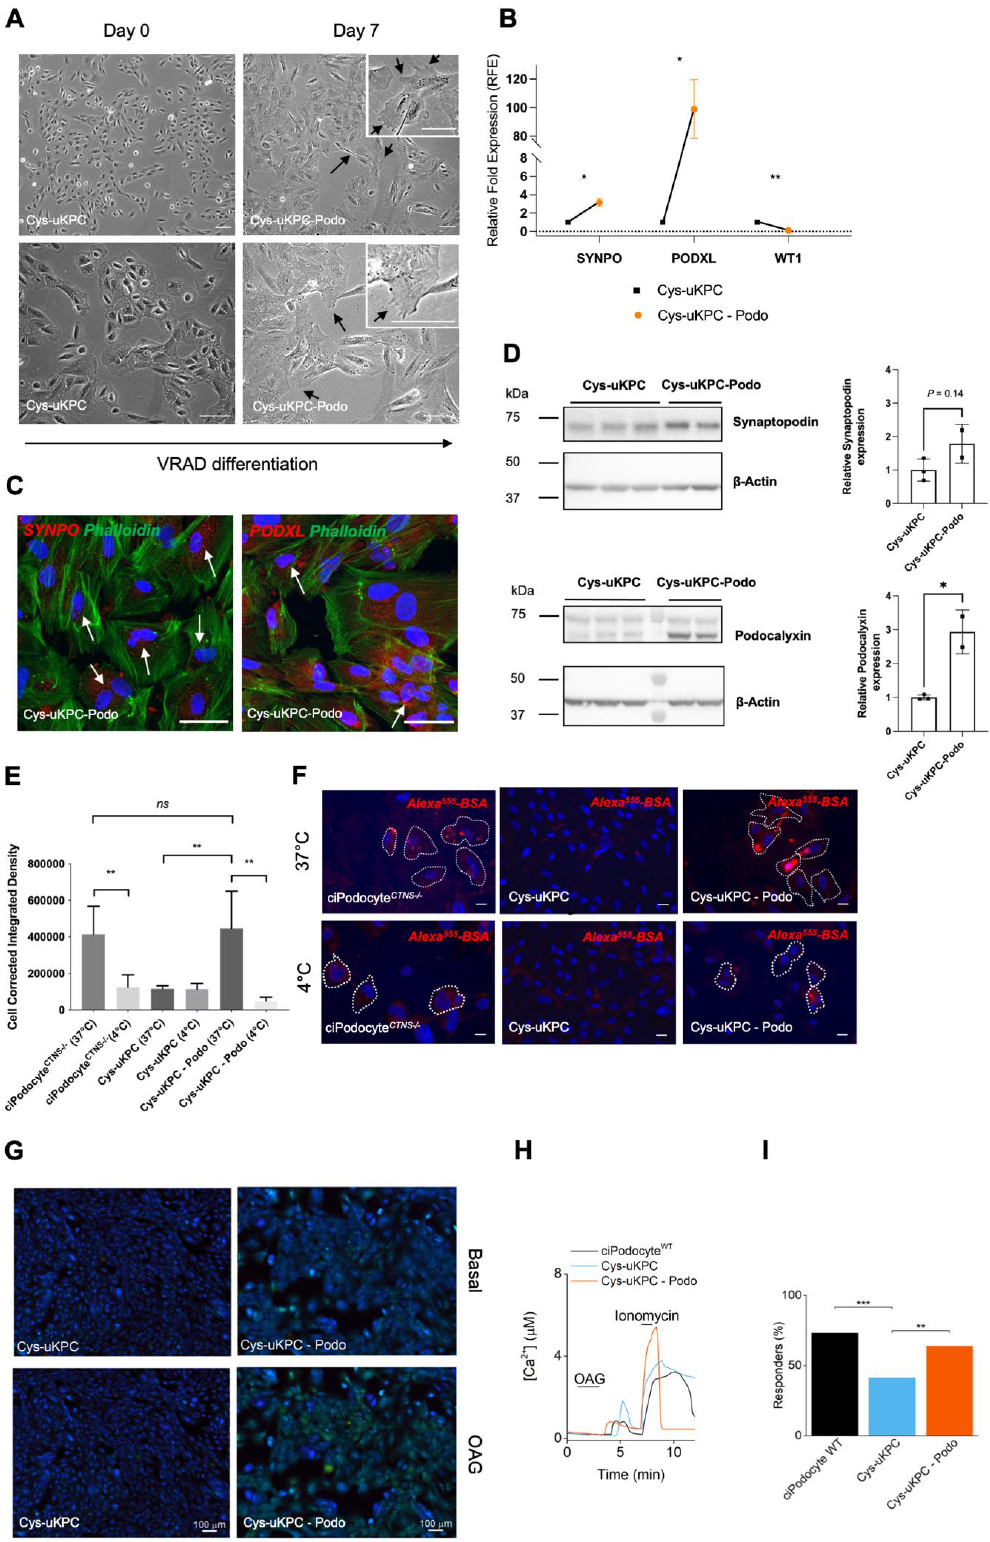
Figure 3. Differentiation of Cys-uKPC in vitro into functional podocytes. ( A ) Phase contrast microscopy of a Cys-uKPC clone with a podocyte fate (Cys-uKPC #1), demonstrating the cellular